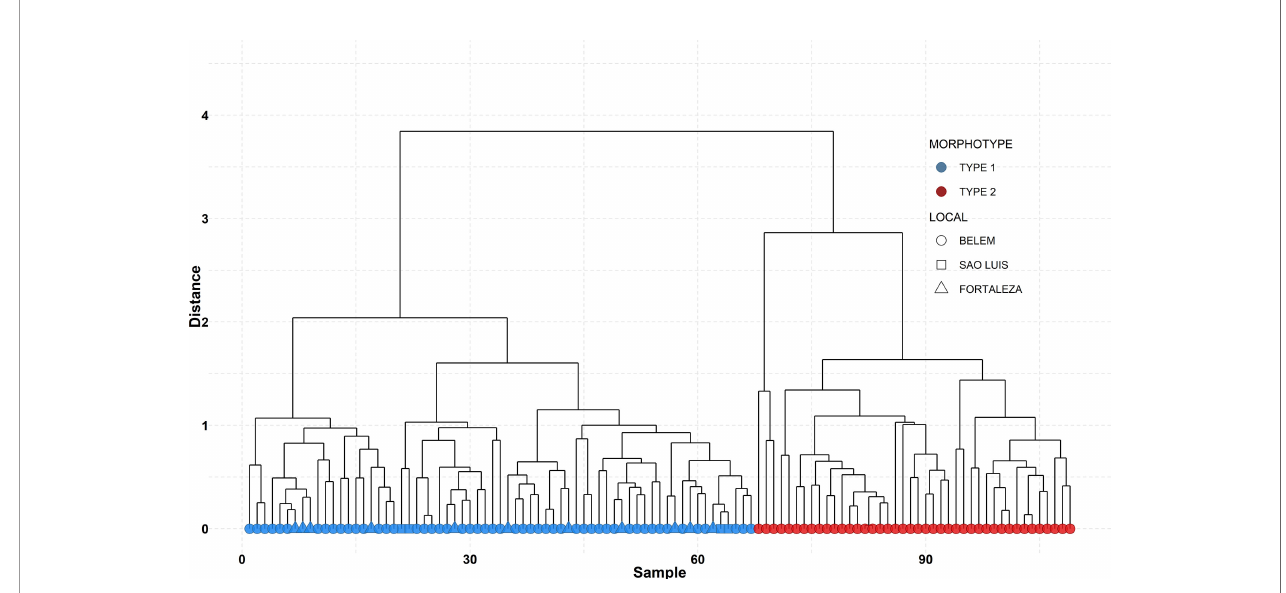
FIGURE 4 | Dendrogram from the clustering analysis showing the two principal clusters separating tooth types. Colors indicate the teeth morphotype groups and symbols indicate the sample ’ s locality in the North and Northeast regions of